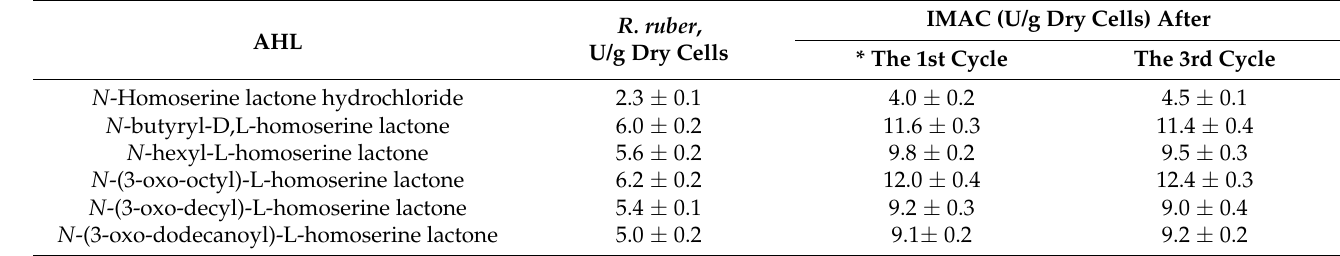
Table 2. Lactonase activity of R. ruber AC-1513D cells and IMAC after its application in the degrada- tion of paraoxon. R. ruber